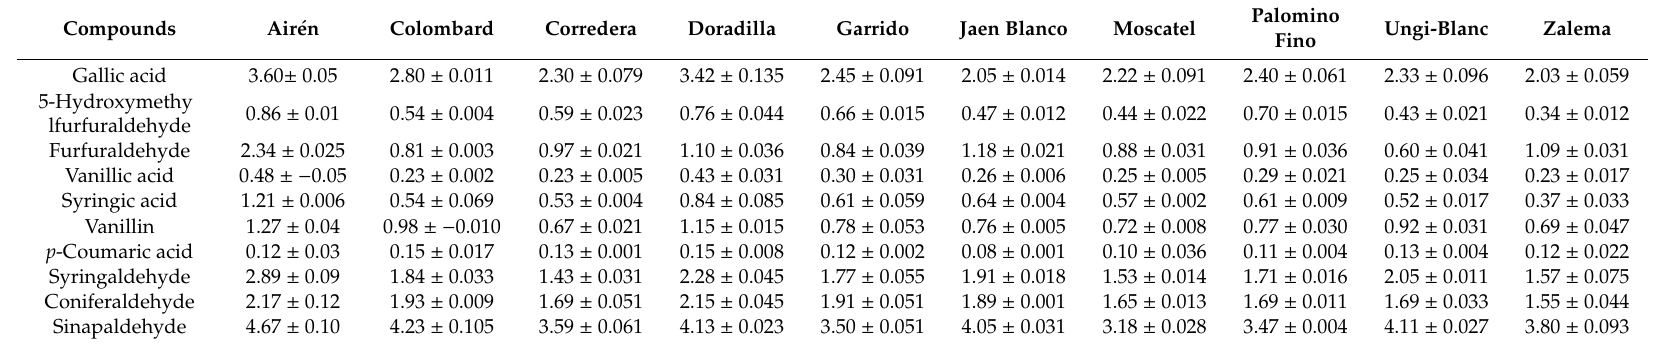
Table 4. Concentrations of polyphenols and furanic compounds of the distillates at the end of the accelerated ageing